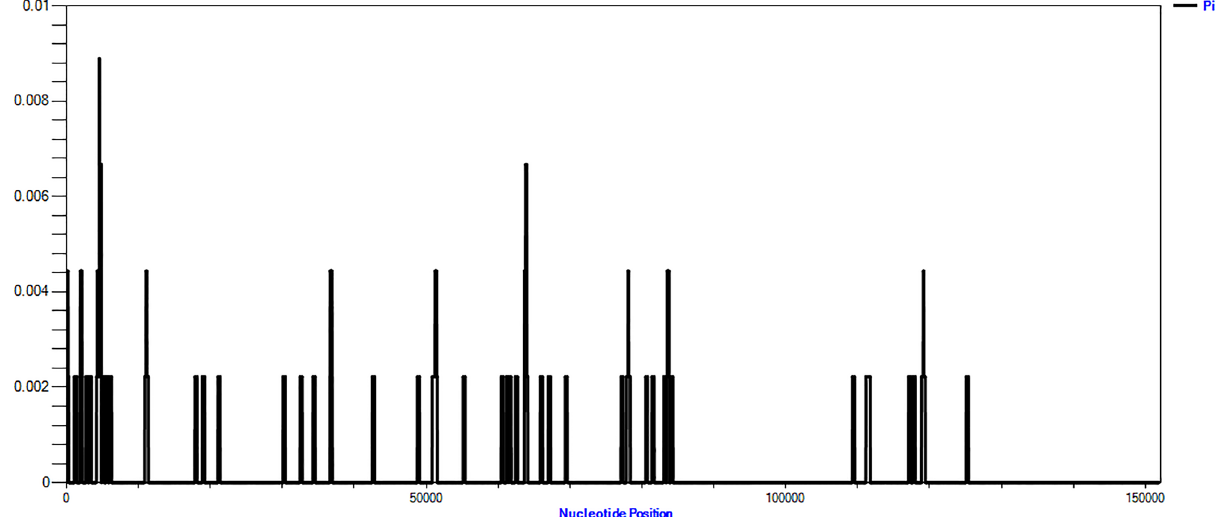
Figure 6. Sliding window analysis of the entire cp genome of three cultivated varieties (window length: 300 bp; step size: 25 bp). X-axis: position of the window; Y-axis: nucleotide diversity of each window.